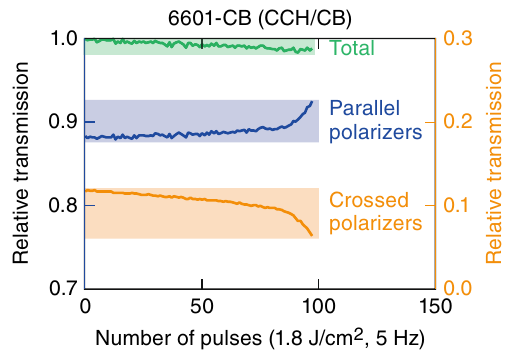
Figure 10. Multipulse LIFT testing at 351 nm for 6601-CB. Addition of unsaturated chiral-dopant CB-15 in concentrations as low as 1 wt% produces nearly immediate degradation under multipulse